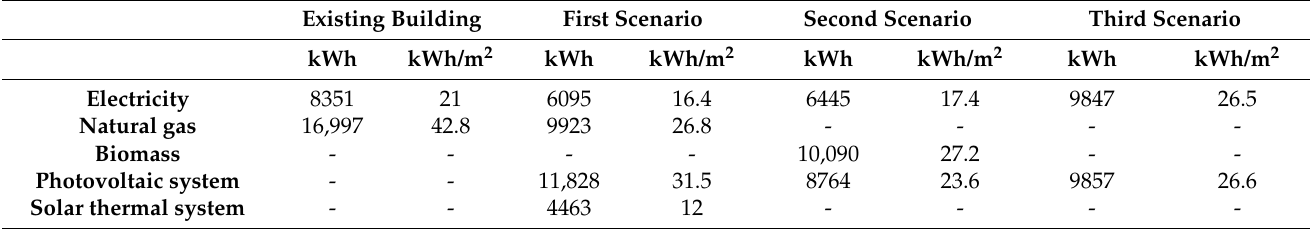
Table 6. Energy comparison between the current state and the three proposed scenarios.